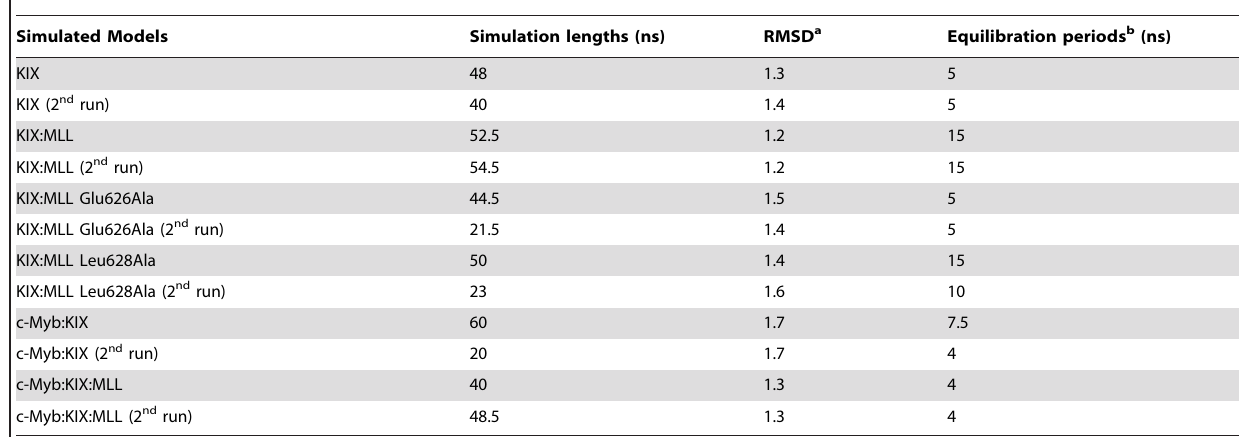
Table 1. Simulation summary.